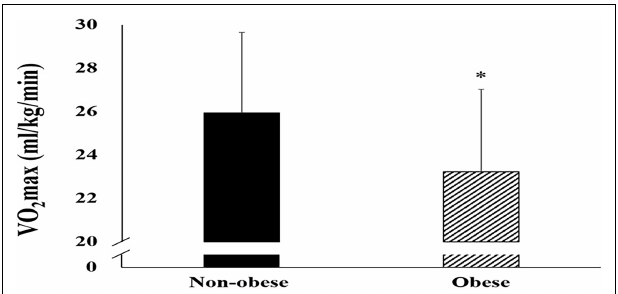
FIGURE 2 | Difference in maximal oxygen uptake (mean ± SD) between non-obese and obese. SD, standard deviation and VO 2 max, maximal oxygen uptake. * p < 0.05; ** p < 0.01; *** p < 0.001 vs.